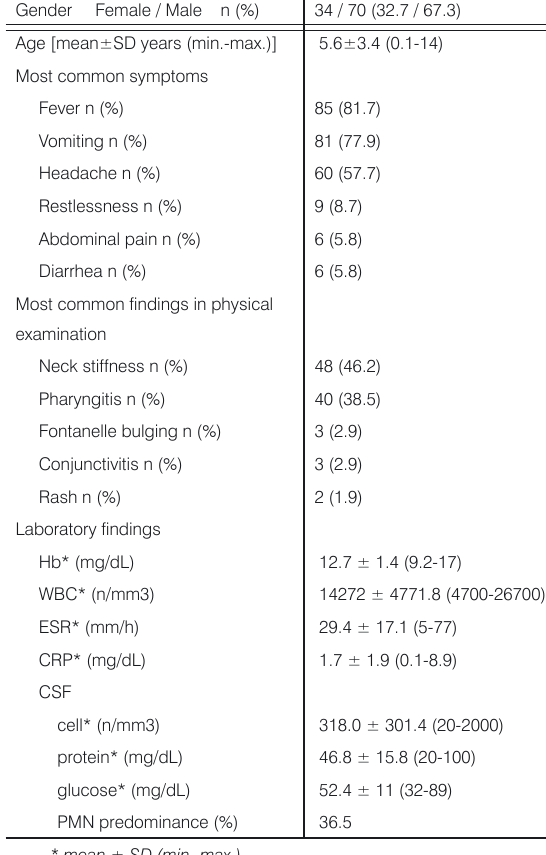
Table 1. Clinical features and laboratory findings in 104 patients with enteroviral